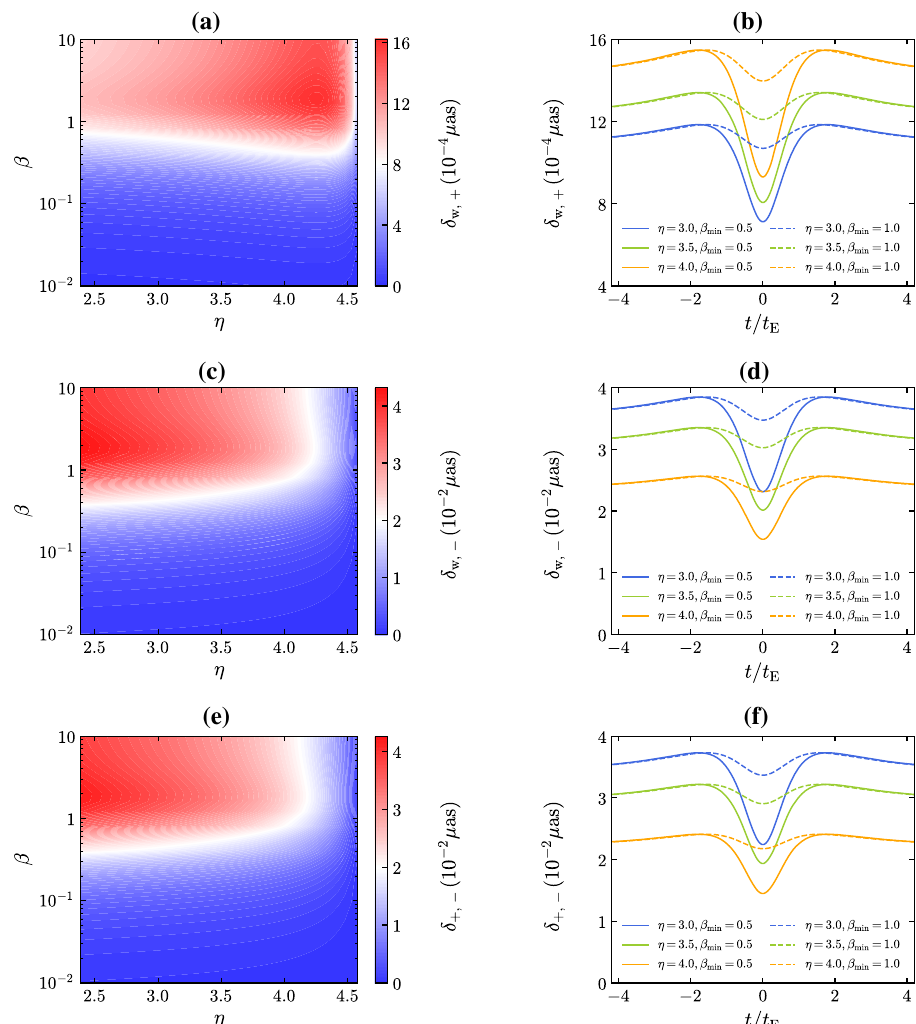
Fig. 8 Left column: the color-indexed centroid shift δ δ + , − on the domain of w , ± and (η,β) . Right column: their time evolution during crossing the Einstein